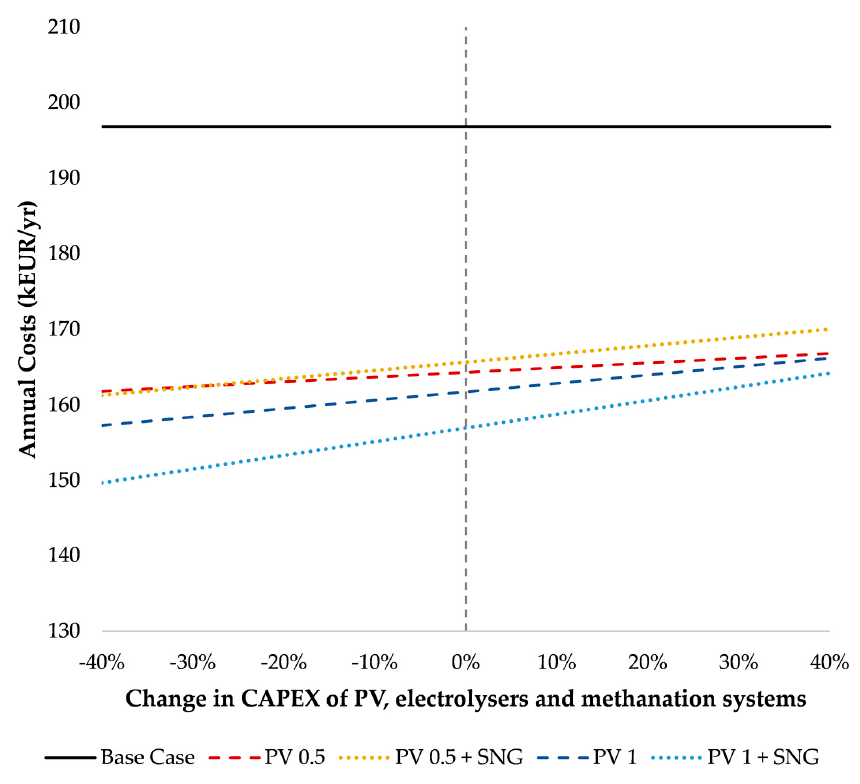
Figure 12. Sensitivity analysis of annual costs by changing the CAPEX of PV, electrolyser and methanation systems.